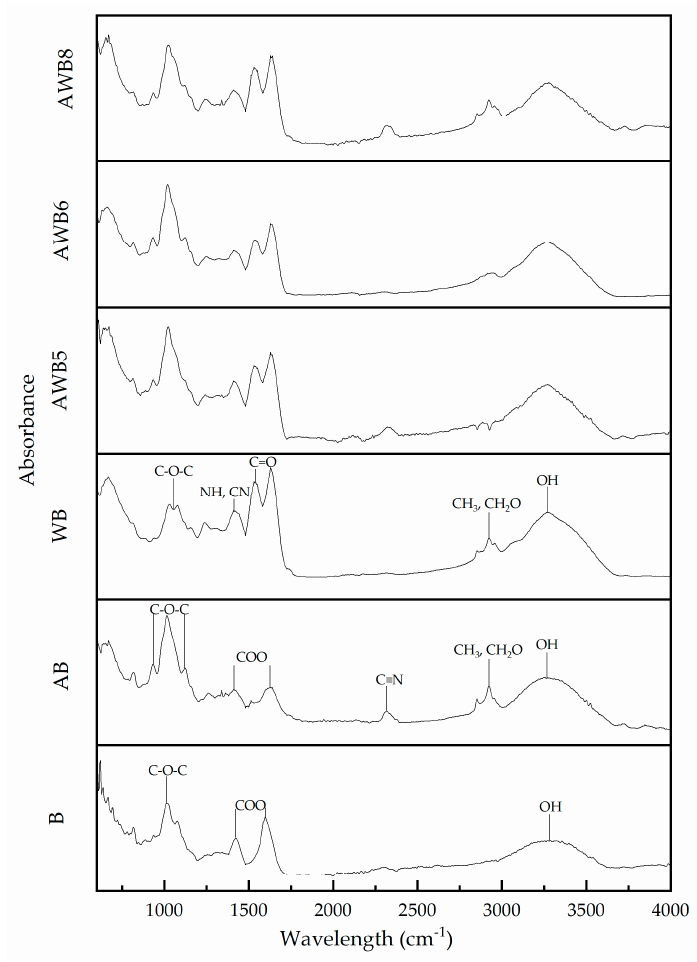
Figure 4. FT-IR absorbance spectra for each of the different beads with S. boulardii .